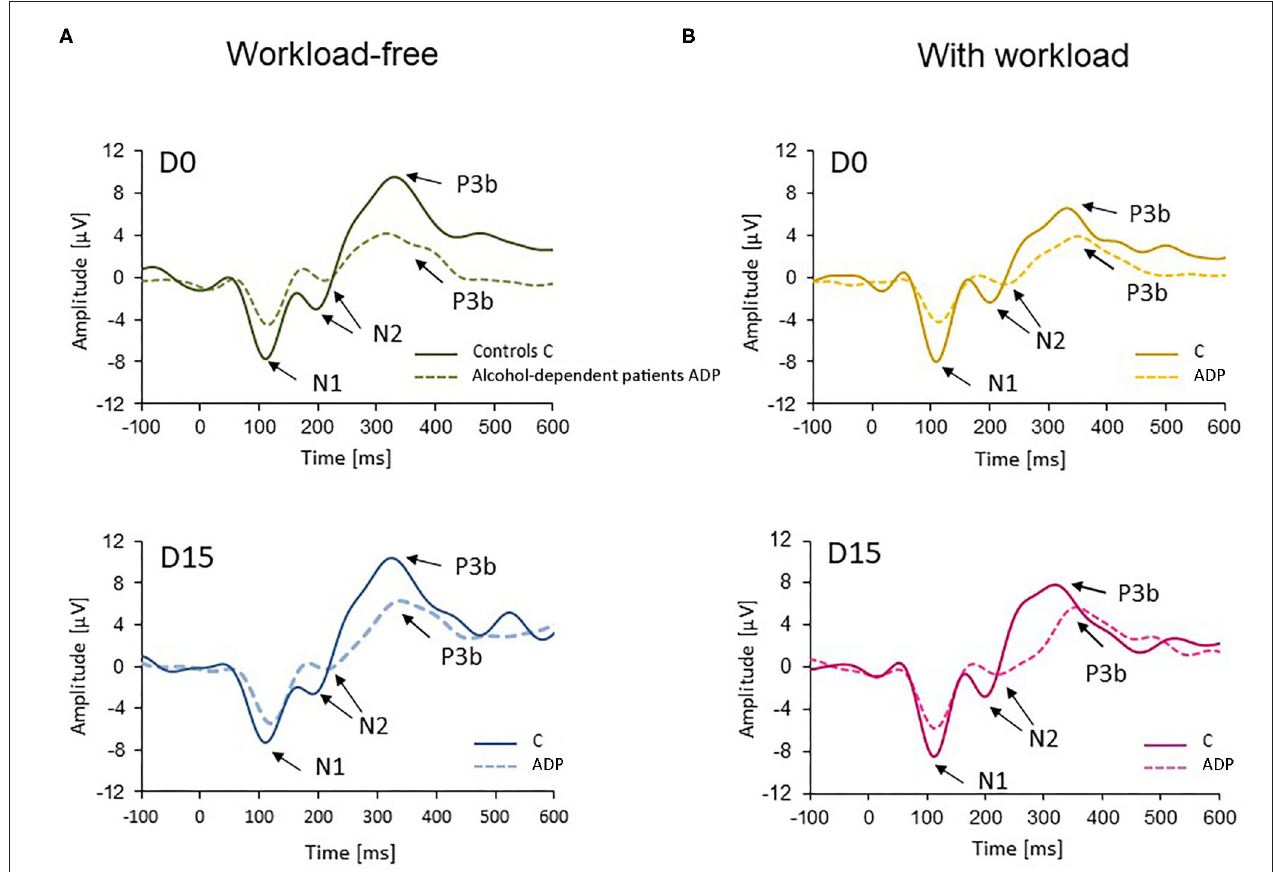
FIGURE 1 | Grand average waveforms at central (C3, Cz, and C4 combined) electrode sites for controls (C, solid lines) and alcohol-dependent patients (ADP, dotted lines) at D0 (upper panels, green and yellow) and D15 (lower panels, blue and pink) during (A) the workload-free task, and (B) the workload task for infrequent target auditory